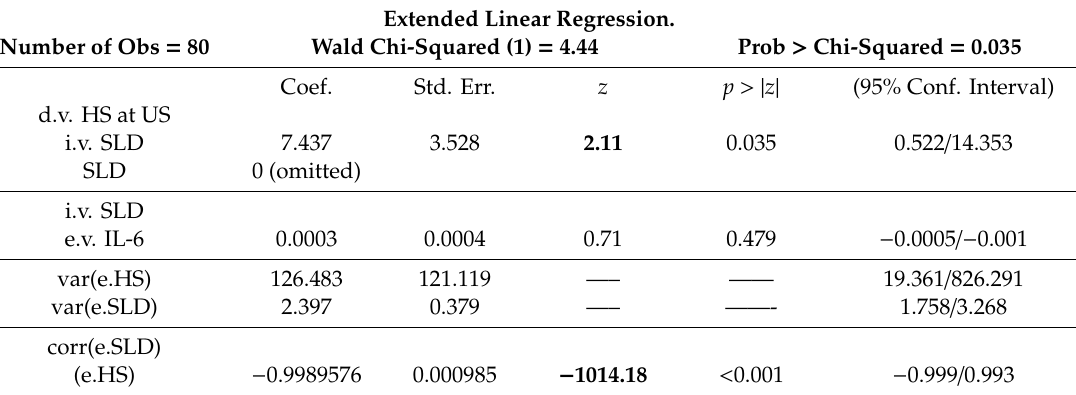
Table 10. Evaluation of the influence of Il-6 levels in predicting HS by SLD. Extended Linear Regression.